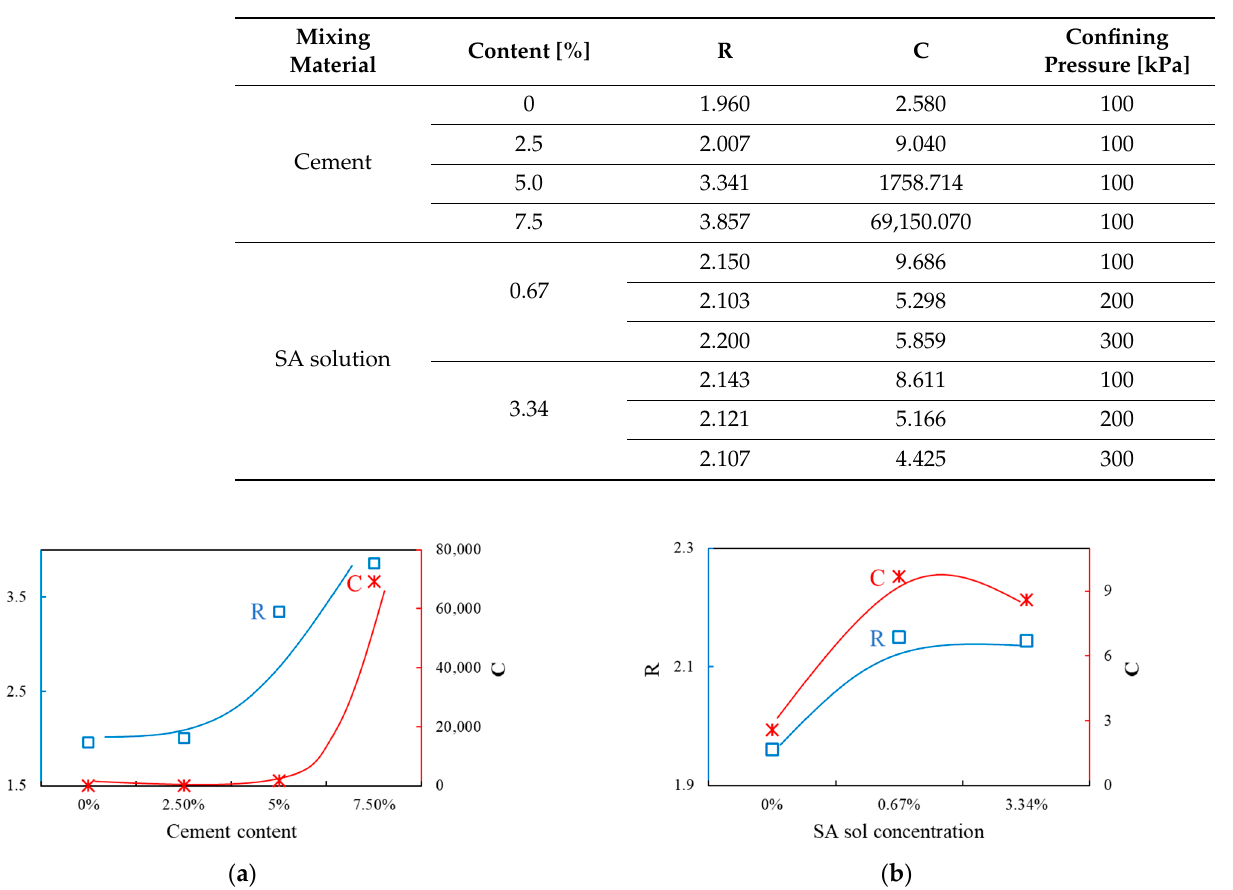
Table 5. Ramberg-Osgood model parameters.